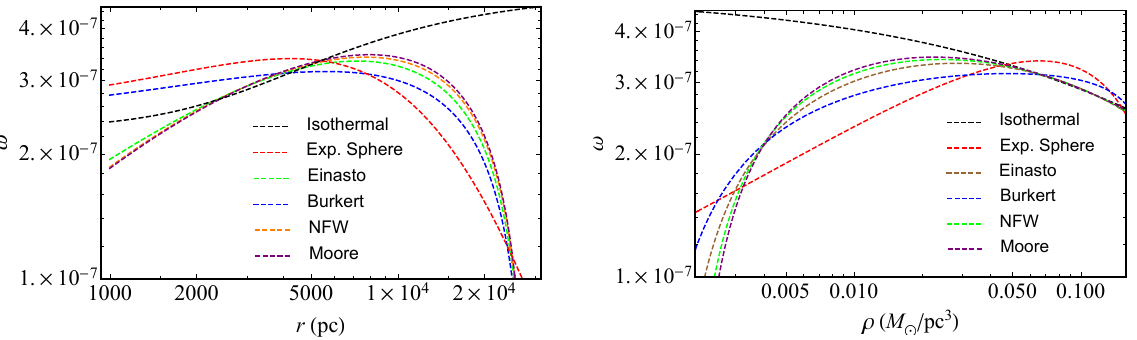
Figure 3. Color online. Left panel: Dimensionless state parameter ω as a function of radial coordinate r . Right panel: Dimensionless state parameter ω as a function of density ρ .